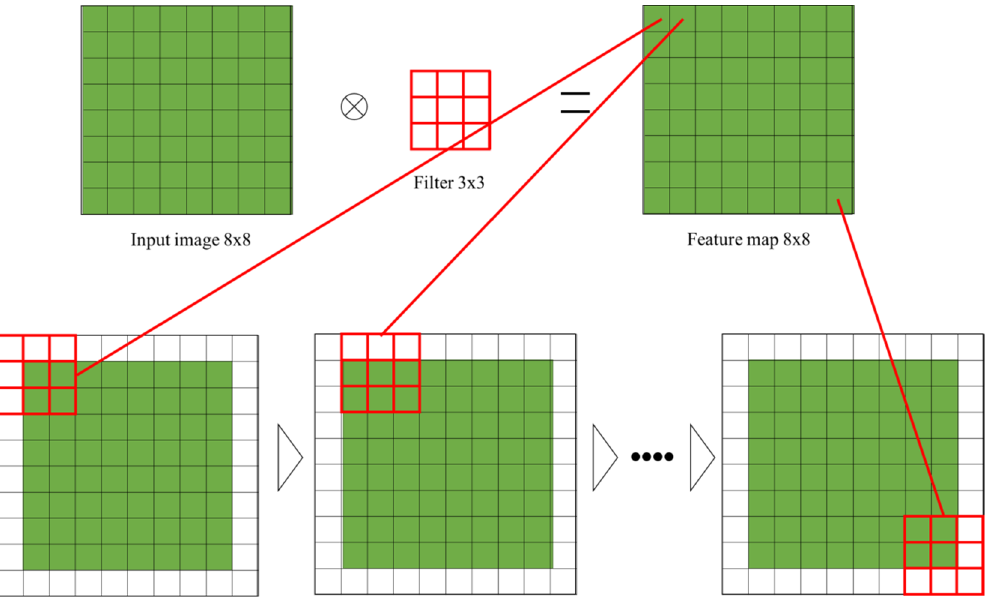
Figure A2. Sample image for a 3 × 3 convolution with stride one and zero-padding.